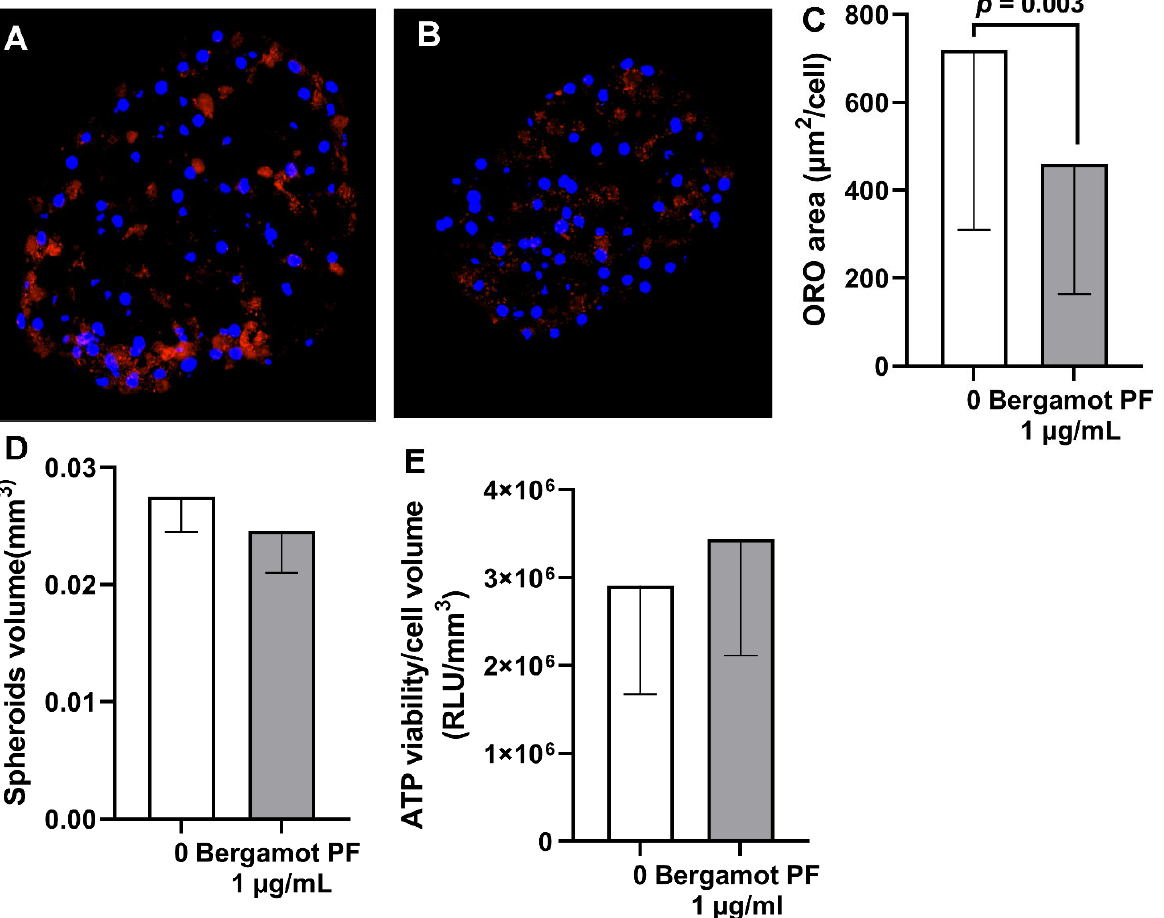
Figure 5. Treatment with 1 µ g/mL bergamot PF extract reduces intracellular lipid content in human liver organoid. ( A ) Human liver organoid was cultured as 3D spheroids for a total of 7 days. Initially, 48 h after seeding, the media was replaced every 48 h. Objective 20X. ( B ) Human liver organoid was cultured as 3D spheroids for a total of 7 days. Initially, 48 h after seeding, the media was supplemented with 1 µ g/mL bergamot PF extract for an additional 5 days with media replacement every 48 h. Objective 20X. ( D ) The average volume was calculated by measuring their long and short diameter using ZEN 2.3 Lite software (Zeiss). ( E ) For both spheroids, cellular ATP levels remained stable between the experimental groups. ( C ) Intracellular lipid content measured by Oil red-O staining showed a significant reduction after incubation with bergamot PF extract. Data are shown as mean ± SD of three independent experiments. The p values were calculated by using a Mann–Whitney non-parametric test. Abbreviations are as follows: PF, polyphenols fraction; 3D, three dimensional; SD, standard